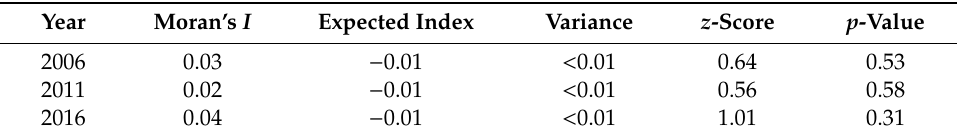
Table 4. Spatial autocorrelation analysis of diarrhea prevalence in children under five years old in Nepal, categorized by the survey year.